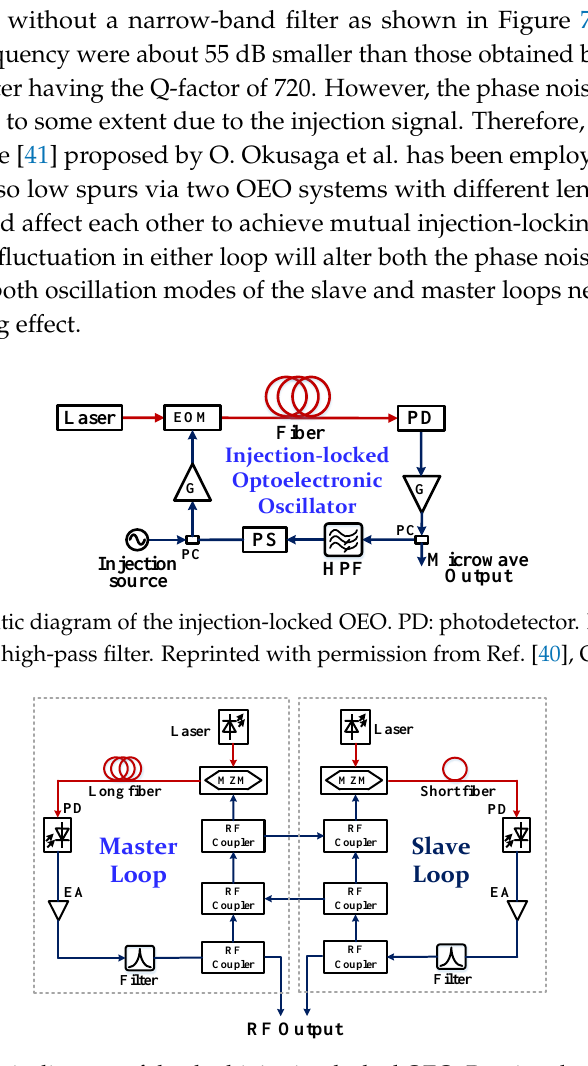
Figure 9. The schematic diagram of the OEO employing a WGM resonator. WGM: whispering gallery mode. PC: polarization controller. PD: photodetector. LNA: low noise amplifier. Reprinted with permission from Ref. [26], OSA, 2018 .